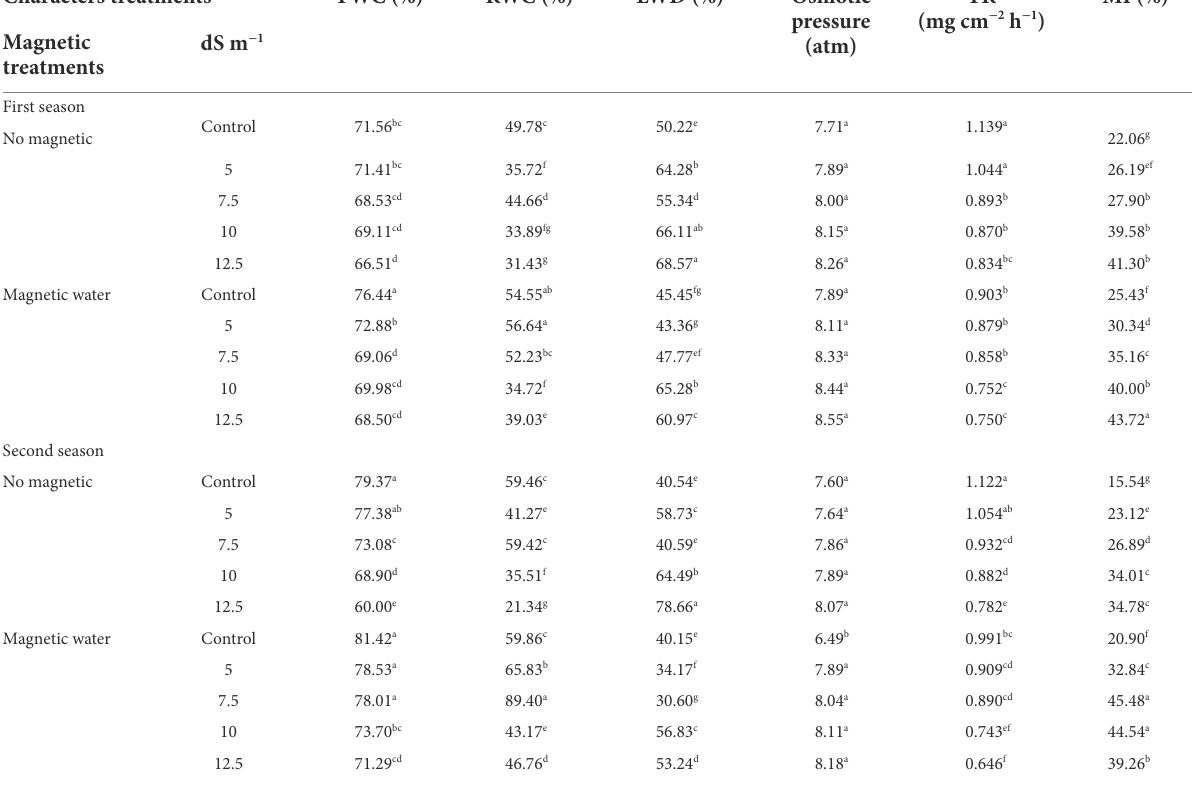
TABLE 3 Effect of seawater stress levels, magnetic treatment on water relation in leaves of wheat plants during the first and second growing seasons. Characters